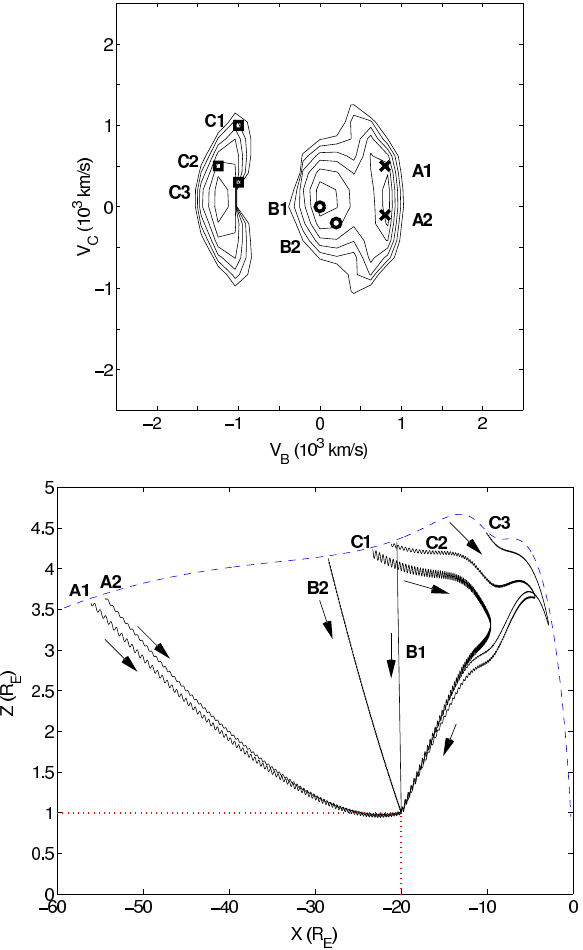
Fig. 12. (Top) Model two-dimensional ion velocity distribution in the V B − V C plane, calculated at (X,Y,Z) = ( − 20 , 0 , 1 ) R E . Several initial positions in velocity space are selected in order to demonstrate the representative behaviour of particles comprising the core and beam components of the distribution. The particles comprising part of the earthward moving beam are labelled with crosses and points A1, A2. The sample particle orbits from the core component are labelled as circles and B1, B2. For the coun- terstreaming component the labels are squares and C1, C2, C3. The lower figure shows the trajectory traces corresponding to the initial conditions chosen in the upper figure. Arrows show the direction of particle motion.